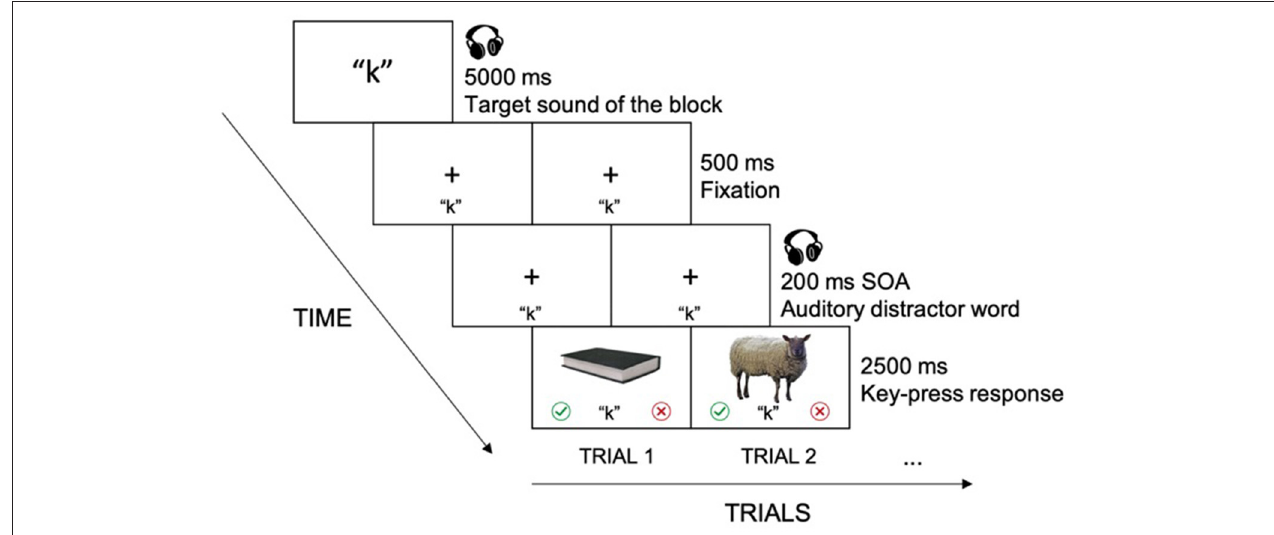
FIGURE 1 | Picture-word interference experiment flow. Prior to each block, a target sound (e.g., /k/) was assigned, with a corresponding letter being presented visually and the corresponding sound being presented auditorily. In each trial, after a 500ms fixation period, an auditory distractor word was shown with an onset of 200ms before the onset of the target picture. The target sound of the block stayed in the lower middle of the screen so that participants would not forget the target sound. The target picture remained on the screen for 2,500ms, and only responses (made by pressing the “J” or “K” key) during that period of time were recorded.